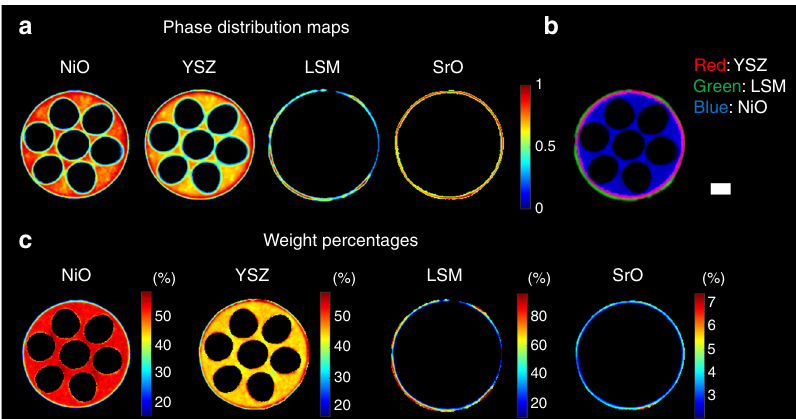
Fig. 2 X-ray diffraction computed tomography of the fresh solid oxide fuel cell. a The phase distribution maps of NiO, YSZ, LSM and SrO as derived from the Rietveld analysis of the fresh SOFC XRD-CT datasets (colour bar indicates intensity in arbitrary units), b red green blue (RGB) image showing the distribution of YSZ (red), LSM (green) and NiO (blue), c weight % of all crystalline phases present in the SOFC. The scale bar corresponds to 0.5